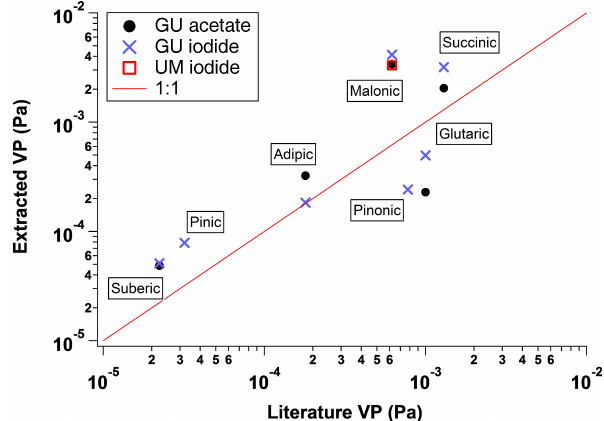
Figure 5. Extracted VP from the UMan and GU FIGAERO-CIMS, plotted against reported subcooled saturation vapour pressures from the literature, through utilization of the PEG calibration. These mea- surements are made using single compounds from the UMan and GU FIGAERO-CIMS (see Table